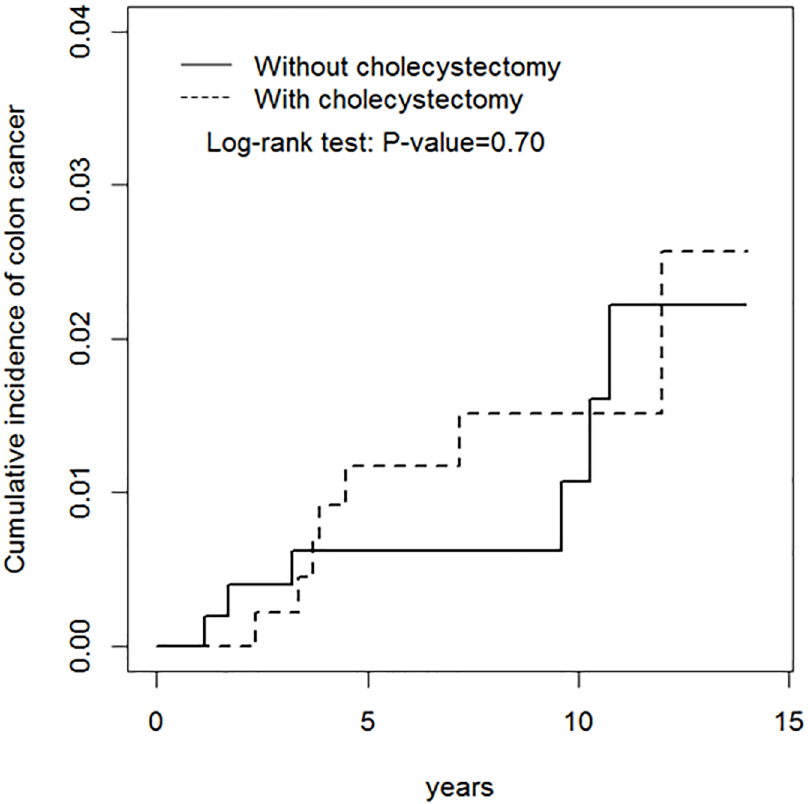
Fig 1. Kaplan-Meir method determined cumulative incidence of colorectal cancer compared between cholecystectomy cohort and non-cholecystectomycohort.